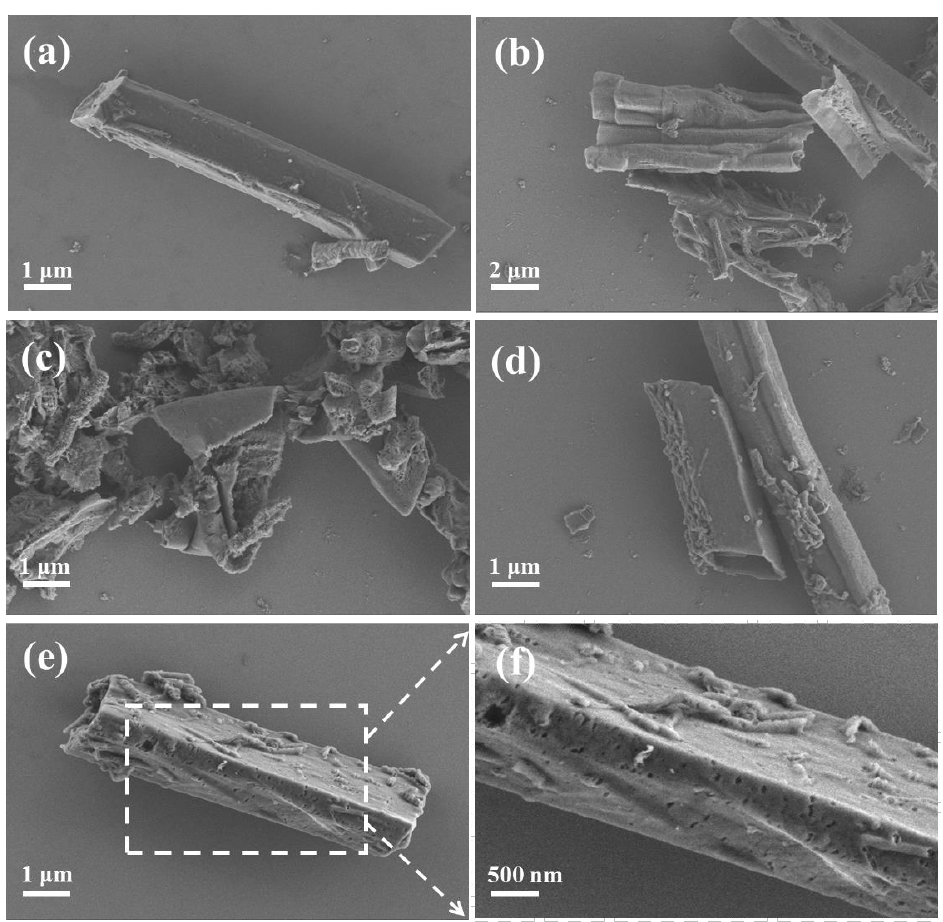
Figure 1. The SEM images of precursor ( a ), CNT ( b ), PCNT ( c ), NCNT ( d ), PNCNT ( e ) and the surface situation of PNCNT samples ( f